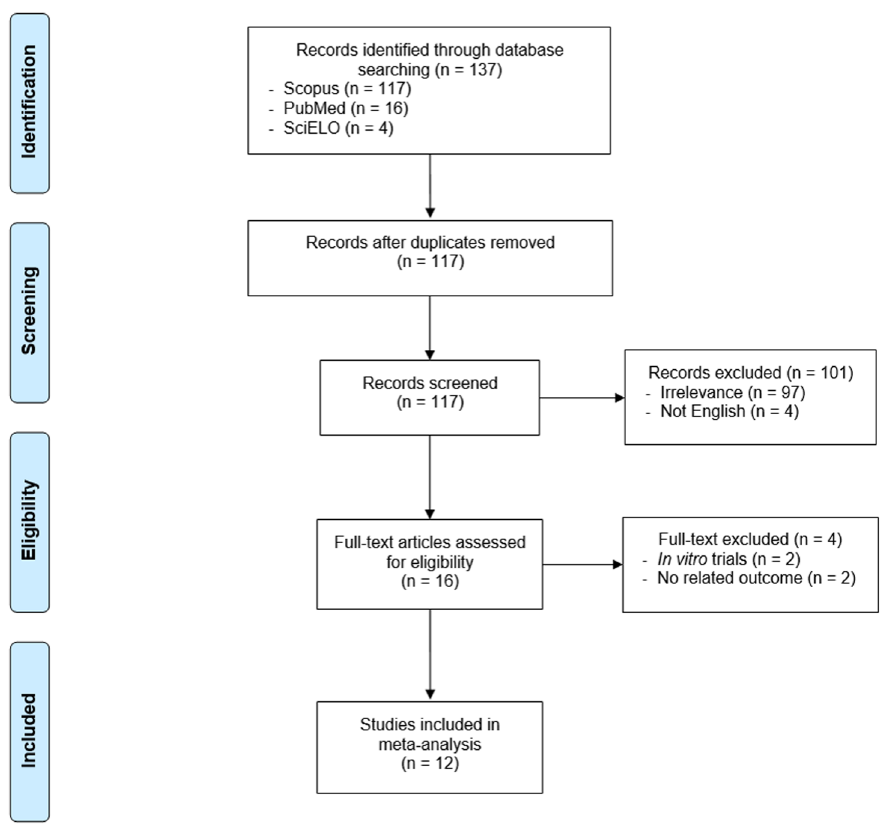
Figure 1. PRISMA flow